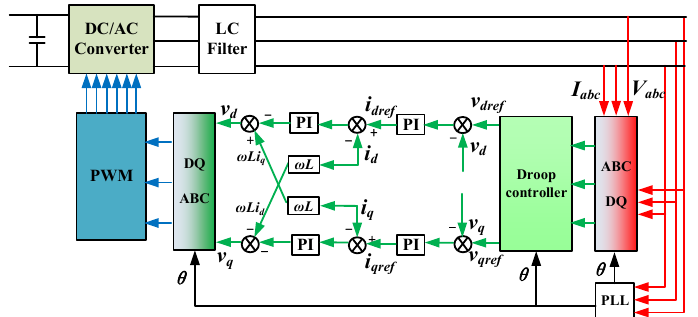
Figure 4. Control principles of energy storage DC ‐ AC converter.